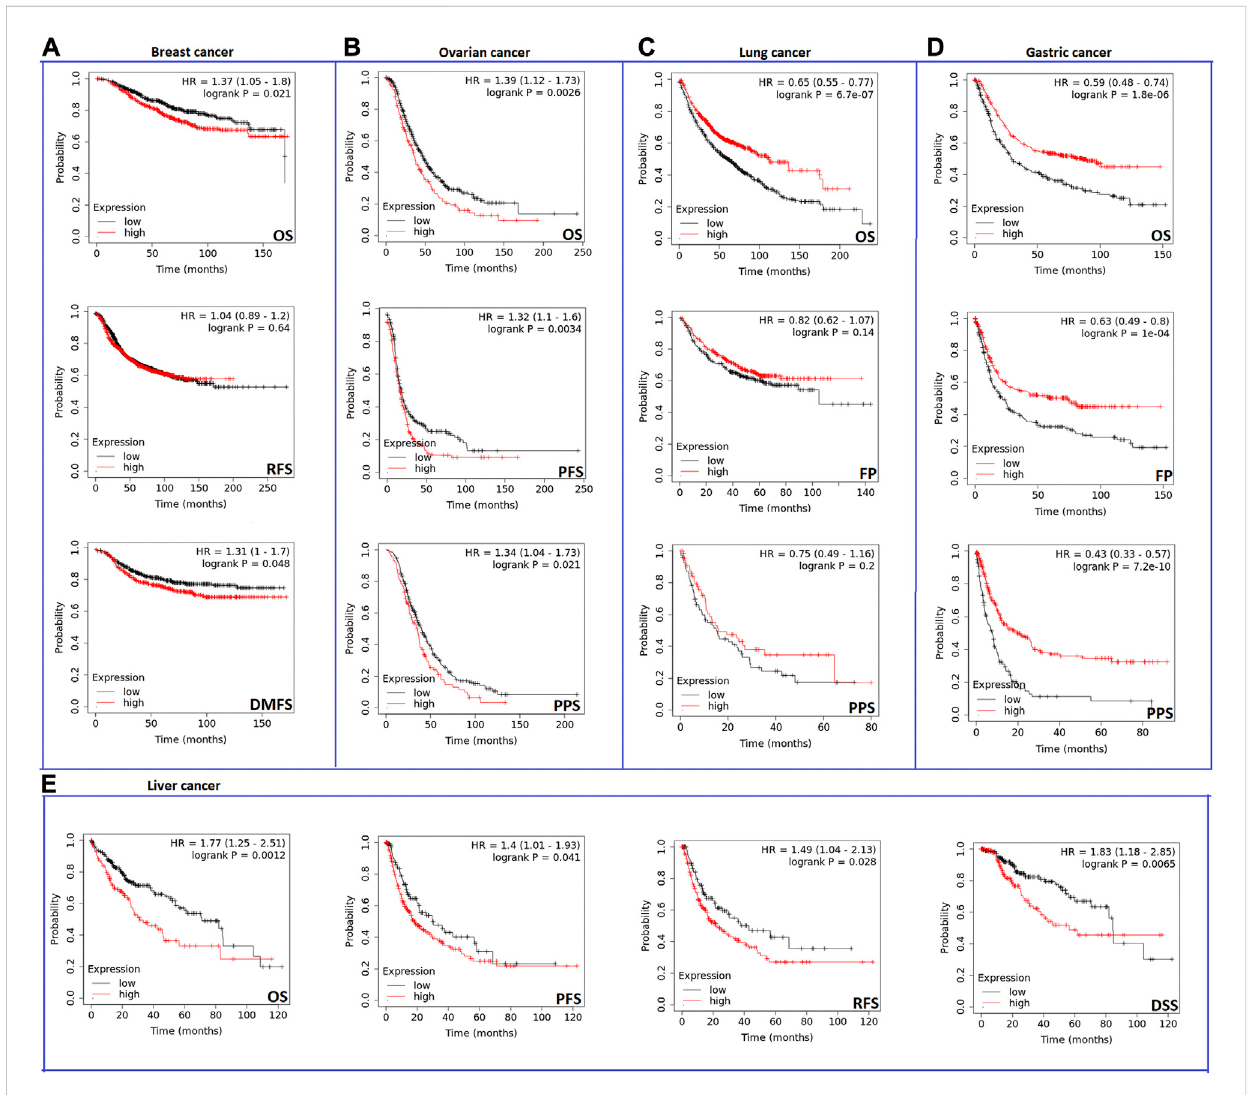
FIGURE 4 The correlation between CHD1L expression and the survival prognosis as assessed with Kaplan – the Meier plotter tool for (A) Breast, (B) Ovarian, (C) Lung, (D) Gastric, and (E) Liver